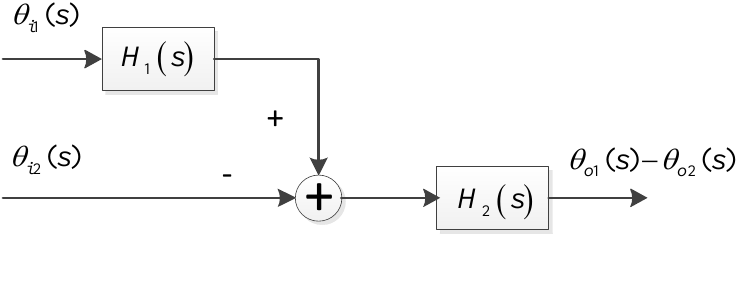
Figure 5. Equivalent structure of the differential phase